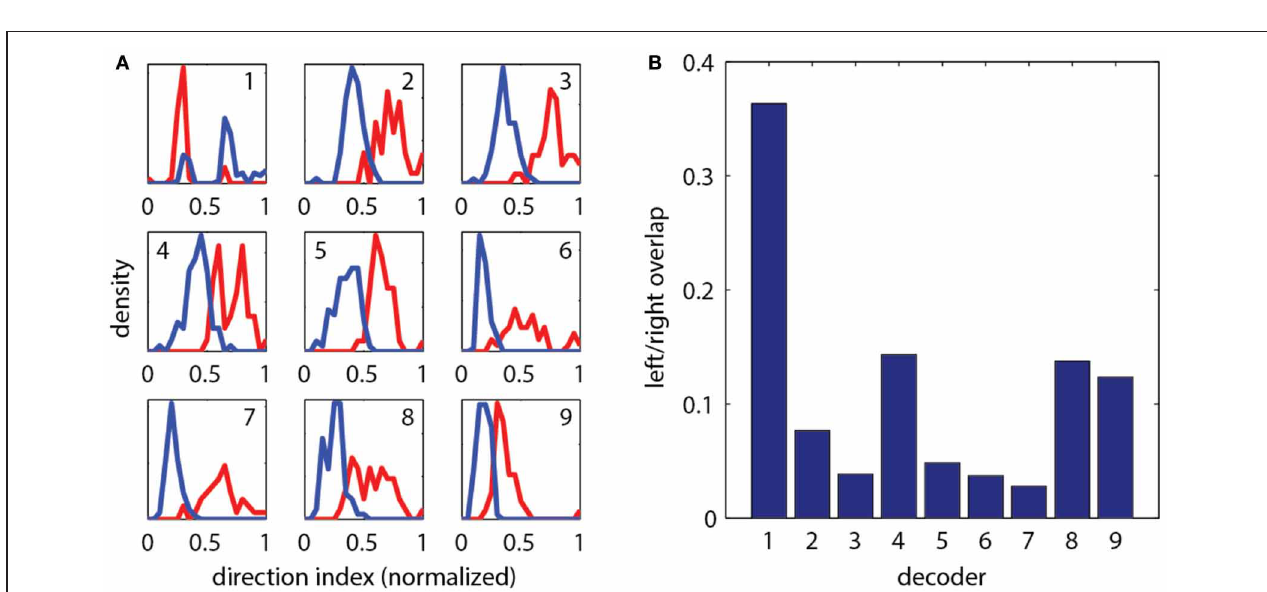
FIGURE 1 | Electrical signatures of fictive forward swims and turns in paralyzed fish. (A) Fictive virtual-reality setup. A larval zebrafish is paralyzed, head-embedded in agar or suspended from pipettes, and suction electrodes record activity from motor neuron axons. Motor neuron activity is used to simulate movement through a virtual environment which is projected on a display underneath the fish. A two-photon microscope records neuronal activity as reported by a genetically-encoded calcium indicator. Right: schematic of the correspondence between free swimming behavior and fictive behavior. In each case, the movement of the world, as seen from the fish’s point of view, is the same. (B) Schematic of the optomotor response (OMR) in a freely swimming fish (top view). Fish turn and swim along with the direction of whole-field motion. (C) Schematic of the goal of the current work. Left: a freely swimming fish makes a left turn (top view). Right: a fictively swimming paralyzed fish intends to make a left turn, upon which the virtual environment projected underneath the fish shifts to induce the same optical translation as observed by the freely swimming fish. (D) Left: example of a fictive forward swim. This was elicited by forward, tail-to-head